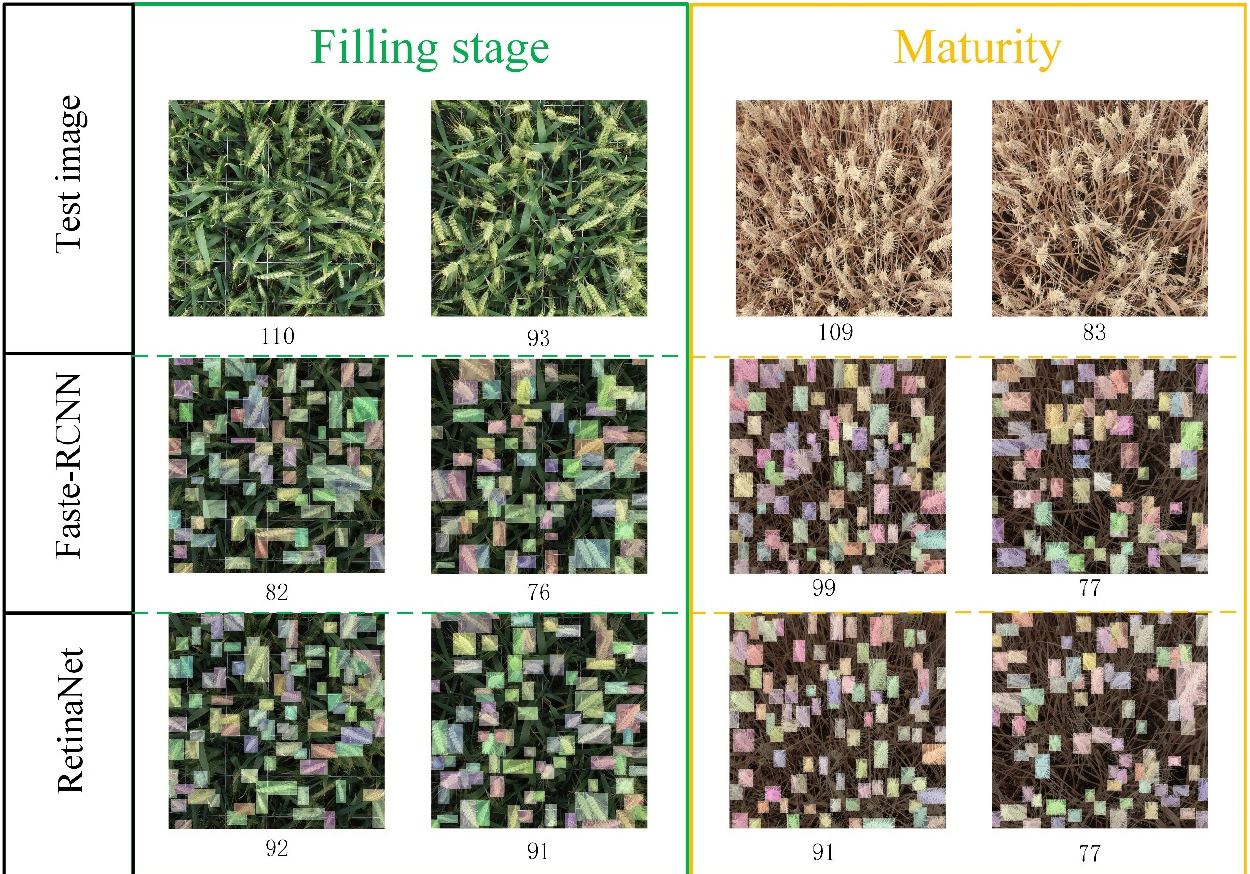
Figure 9. The predicted number of wheat ears (partial) by the Faster R-CNN and RetinaNet models on the test data set.